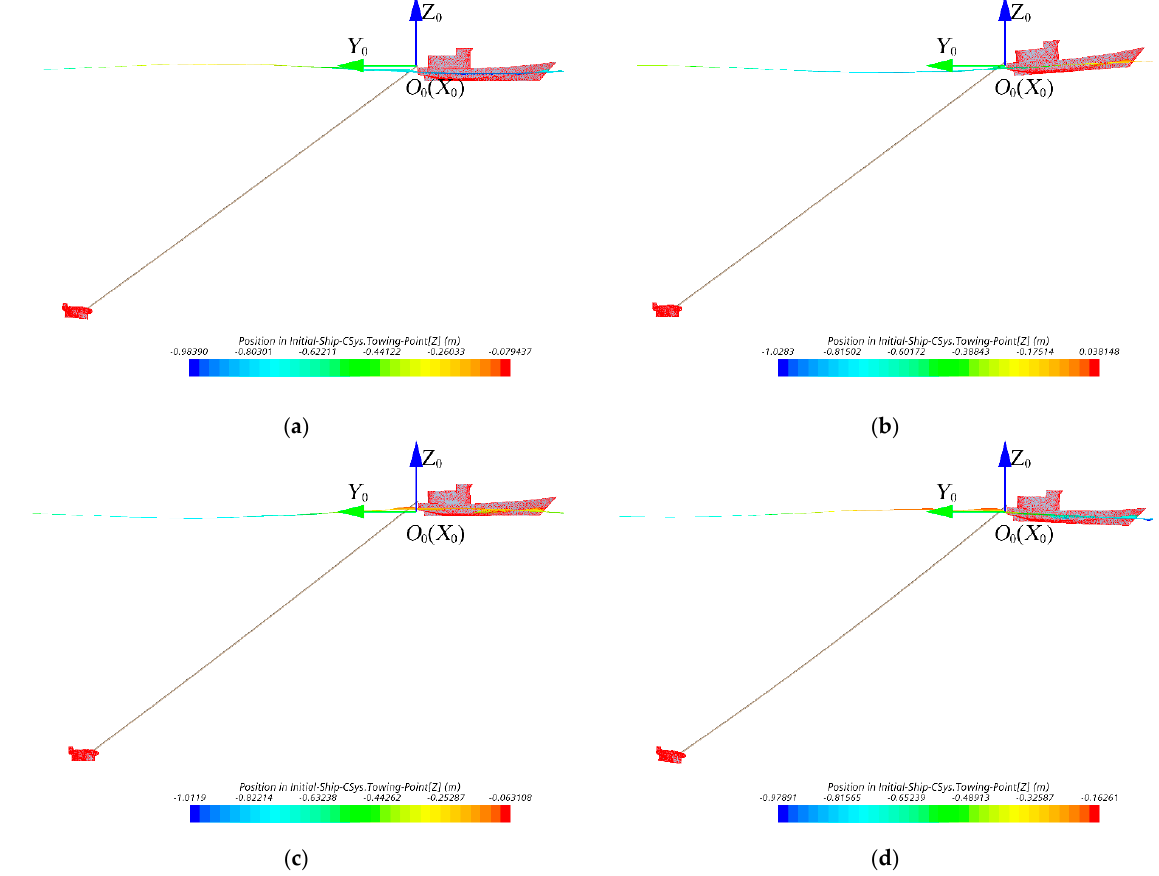
Figure 13. The right view of the head wave and the towed system: ( a ) the towing ship is at the wave trough; ( b ) the towing ship deviates forward by half a wavelength from the wave trough; ( c ) the towing ship is on the wave crest; ( d ) The towing ship deviates forward by half a wavelength from the wave crest.